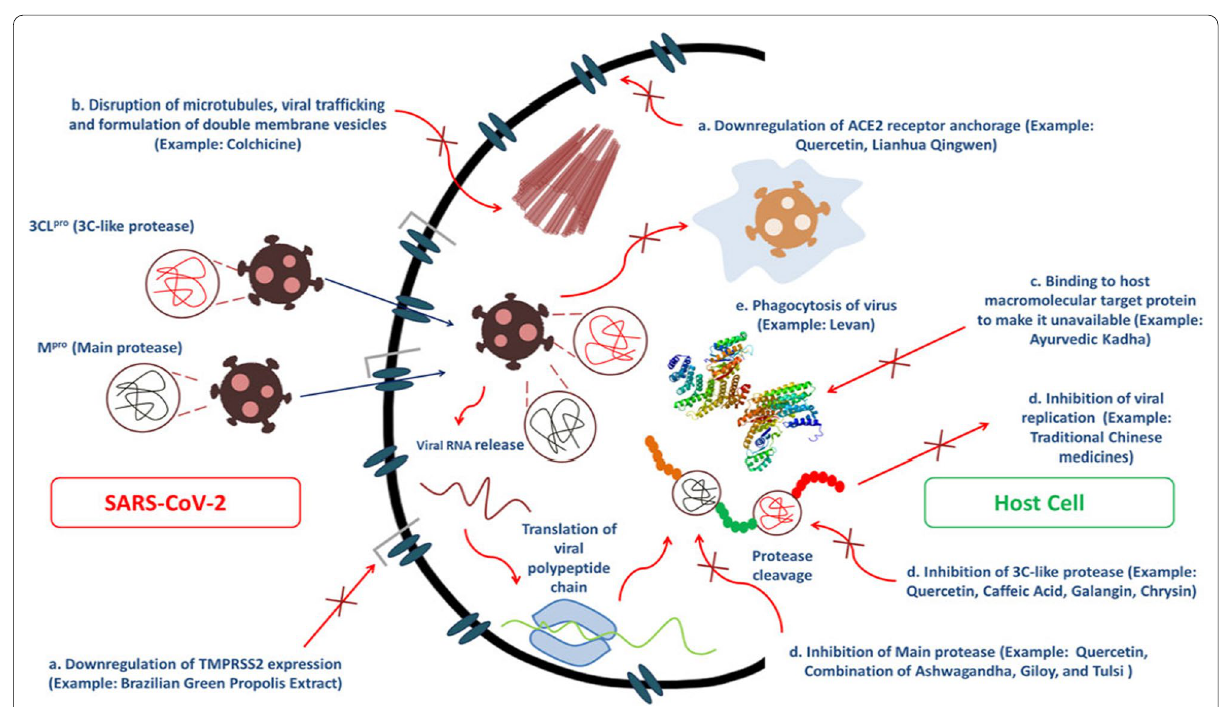
Fig. 1 Several mechanisms of actions of traditional phytomedicines and phytoconstituents to perform anti-SARS-CoV-2 efficacy. “(A) inhibition of main protease and 3C-like protease, (B) Disruption of microtubules, viral trafficking and formulation of double membrane vesicles, (C) Binding affinity toward host macromolecular target protein to make it unavailable and (D) Downregulation of ACE2 receptor anchorage and TMPRSS2 expression which ultimately causes inhibition of viral replication.” (Figure with legend adapted from Alam et al.